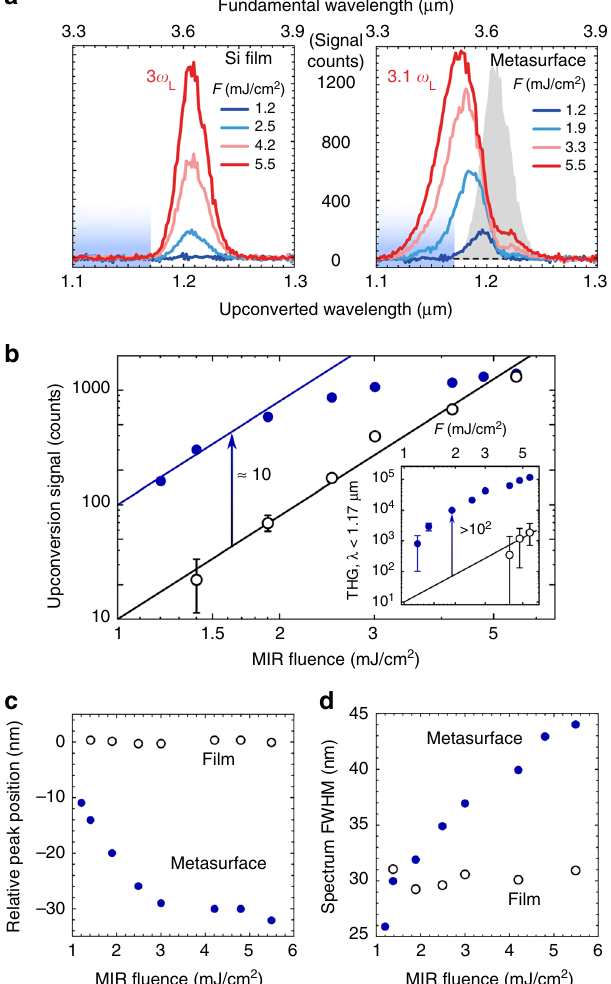
Fig. 2 Spectral characteristics of blue-shifted harmonics in photon accelerating semiconductor infrared metasurfaces (PASIMs). a Third harmonic generation (THG) spectra measured for various input fl uences for the unpatterned Si fi lm and for the metasurface. Shaded gray area: THG from the unstructured fi lm at the highest fl uence F max = 5.5 mJ cm − 2 . Shaded blue areas indicate the integration range of λ TH < 1.17 μ m. b Spectrally integrated third harmonic generation as a function of the mid- infrared fl uence the fi lm (open circles) and metasurface (closed circles), log – log scales. Lines denote the guide-to-the-eye I TH ∝ F 3 dependence. Inset: THG spectrum integrated over 1.1 μ m < λ TH < 1.17 μ m as a function of F for the unstructured fi lm (open circles) and the metasurface ( fi lled circles). The THG spectrum from the PASIM reveals self-induced blue- shifting by ≈ 30 nm ( c ) and broadening by ≈ 50% ( d ) as a function of F ; both effects are negligible for the unpatterned fi lm. Error bars on the plots represent standard errors of the